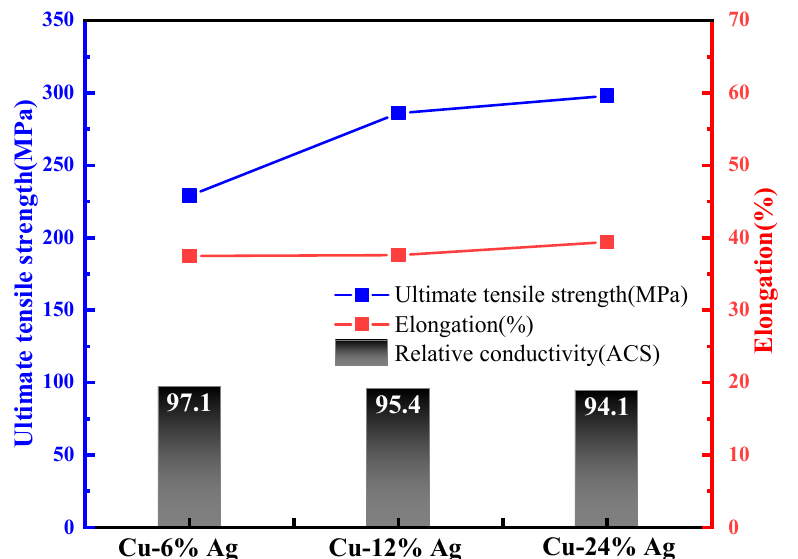
Figure 5. Mechanical-electrical properties of directionally solidified Cu-Ag alloys [88]. Copyright, 2018, Elsevier.